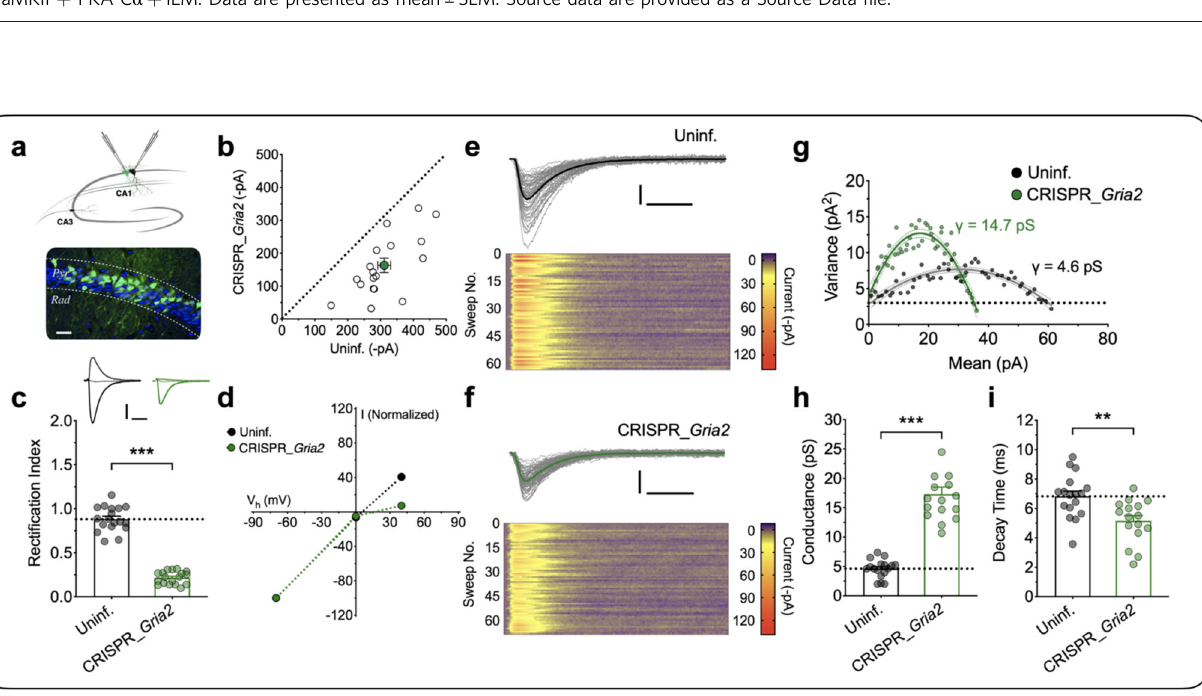
Fig. 6 CaMKII plus PKA C α results in a transient synaptic insertion of CP-AMPARs and increase in γ . a – k Equivalent experiments as described in Fig. 5c – k but with the inclusion of activated CaMKII (250U/mL) plus the catalytic subunit of PKA (PKA C α , 300U/mL) in the internal solution. Scale bars: 10pA and 10 ms. b Pooled results (mean±SEM, 5-min bins) for the effects on EPSC (%) by active CaMKII + PKA C α ( n = 18 neurons from 15 animals, F (2.560,43.52) = 38.34, one-way repeated measures ANOVA), CaMKII + PKA C α + IEM-1460 (IEM, 30 µ M; n = 20 neurons from 15 animals, F (2.064,39.22) = 4.079) and heat- inactivated CaMKII + PKA C α ( n = 16 neurons from 14 animals, F (2.682,40.23) = 1.301). Bonferroni ’ s post hoc multiple comparisons test; * p <0.05, ** p <0.01 and